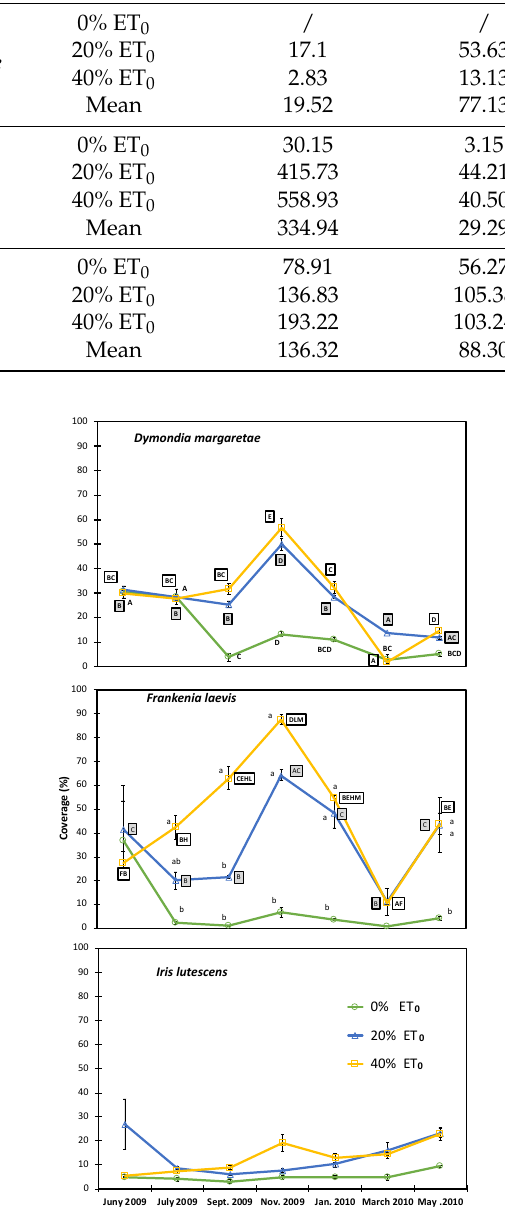
Figure 5. Annual vegetation cover for each species and irrigation treatments (0–20–40% ET 0 ). Capital letters indicate significant differences throughout the trial period for the same treatment. Lowercase letters indicate significant differences between irrigation treatments in the same month.